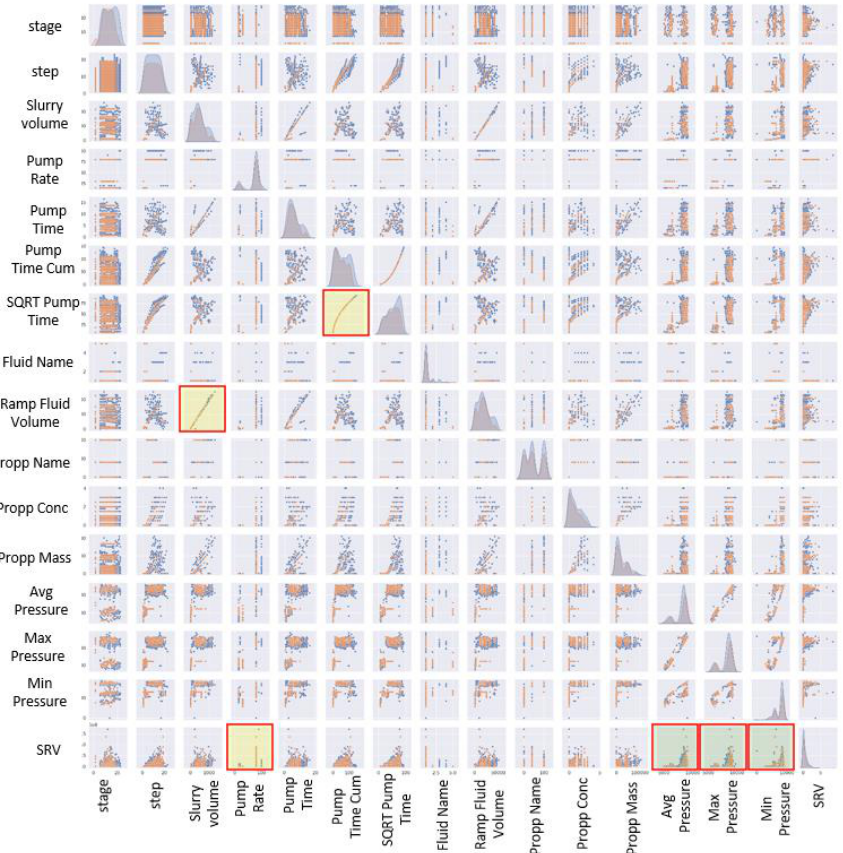
Figure 7. Confusion matrix of all the initial variables. The variables are color-coded for different wells. The variables of MIP-3H are shown in blue colors, and the variables of MIP-5H are shown in orange.